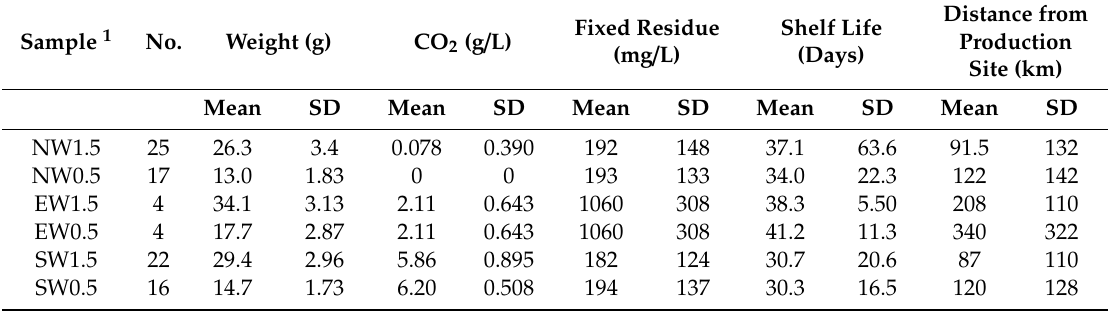
Table 1. Characteristics expressed as mean and standard deviation (SD), of the samples analyzed.